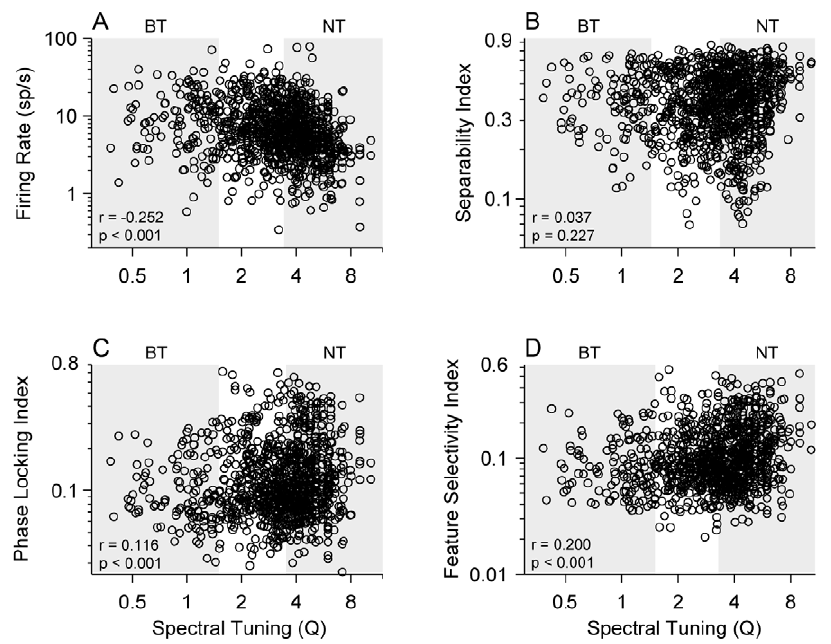
Figure 9. STRF parameters versus spectral tuning (Q). (A) Firing rate is weakly correlated with Q (r= 2 0.252, p , 0.001, t-test). (B) Phase locking index is weakly correlated with Q (r=0.116, p , 0.001, t-test). (C) STRF separability is uncorrelated with Q (r=0.037, p=0.227, t-test). (D) Feature selectivity index is weakly correlated with Q (r=0.200, p , 0.001, t-test). Shaded areas Broadly Tuned (BT) and Narrowly Tuned (NT) neurons.